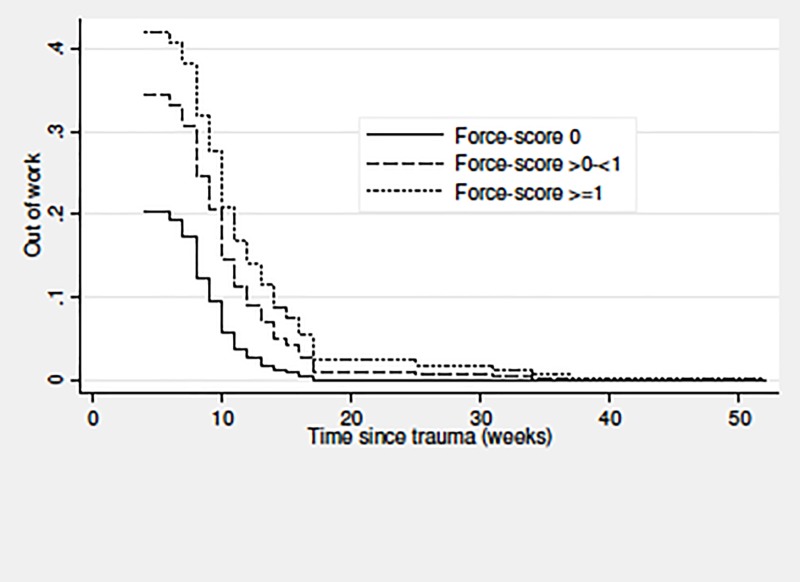
Time (weeks) until return to work for at least four weeks in relation to forceful work (force-score) among patients examined by early MRI on suspicion of scaphoid fracture (n = 125).Plot from multivariable Cox proportional hazard analyses; the Y-axis shows the probability (decimal numbers) of being out of work. Abbreviation: MRI = magnetic resonance imaging.